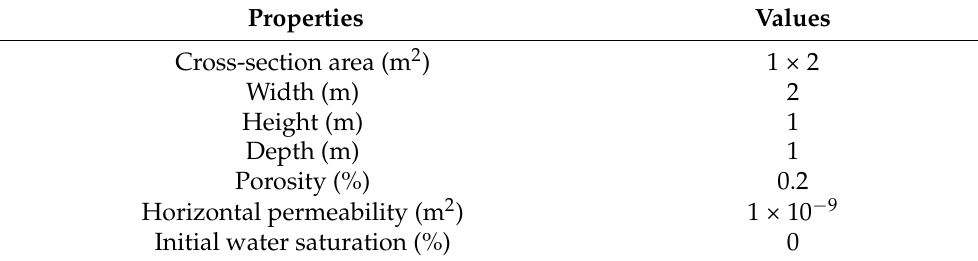
Table 3. PM properties.